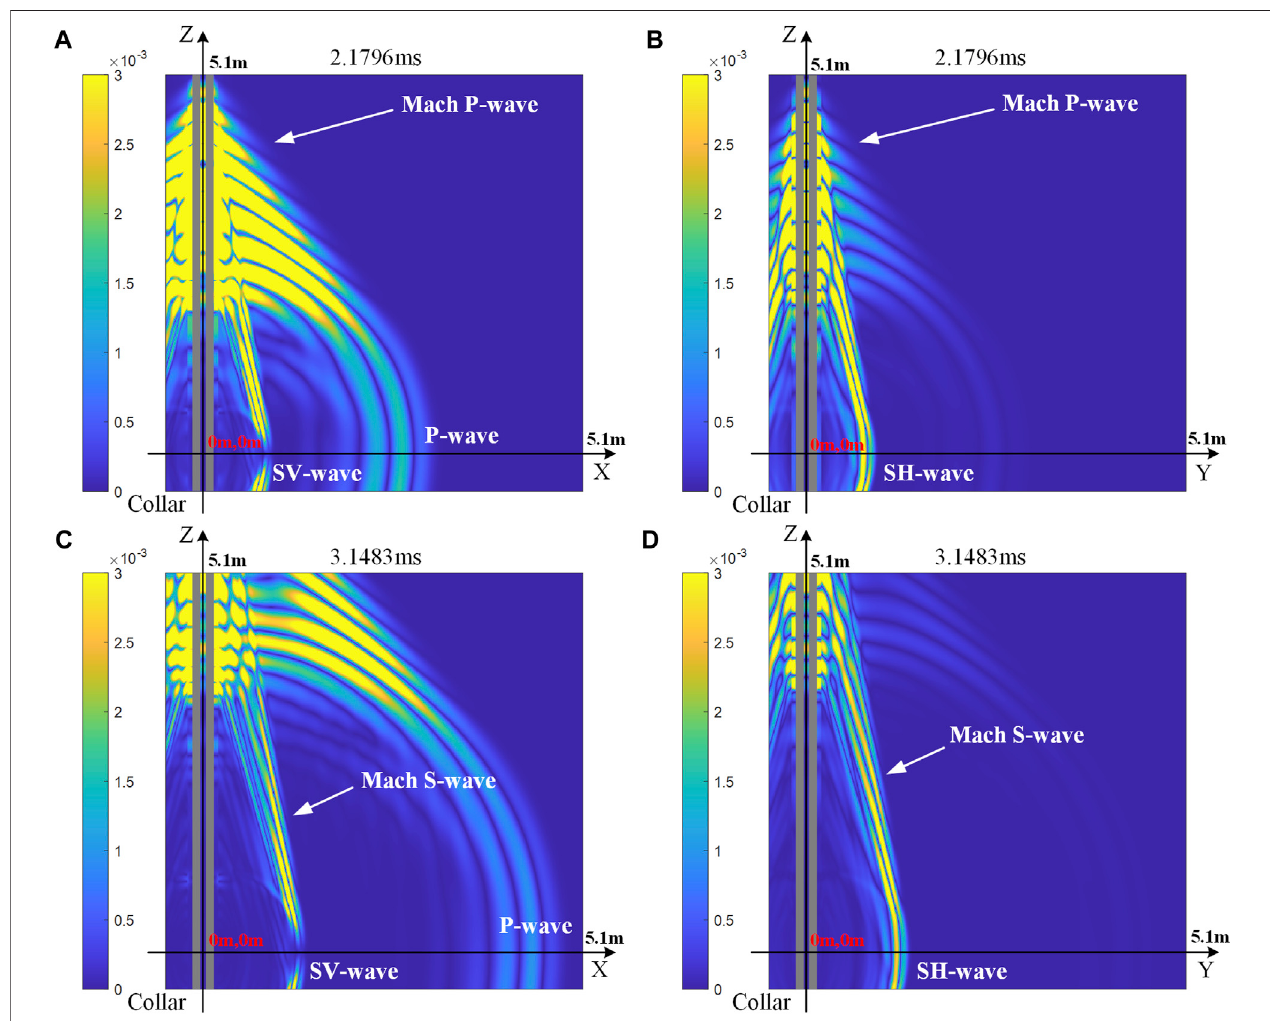
FIGURE 4| The snapshots ofthe total vibration velocity fi elds in (A) xoz -plane at 2.1796 ms, (B) yoz -plane at 2.1796 ms, (C) xoz -plane at 3.1483 ms and (D) yoz - plane at 3.1483 ms.